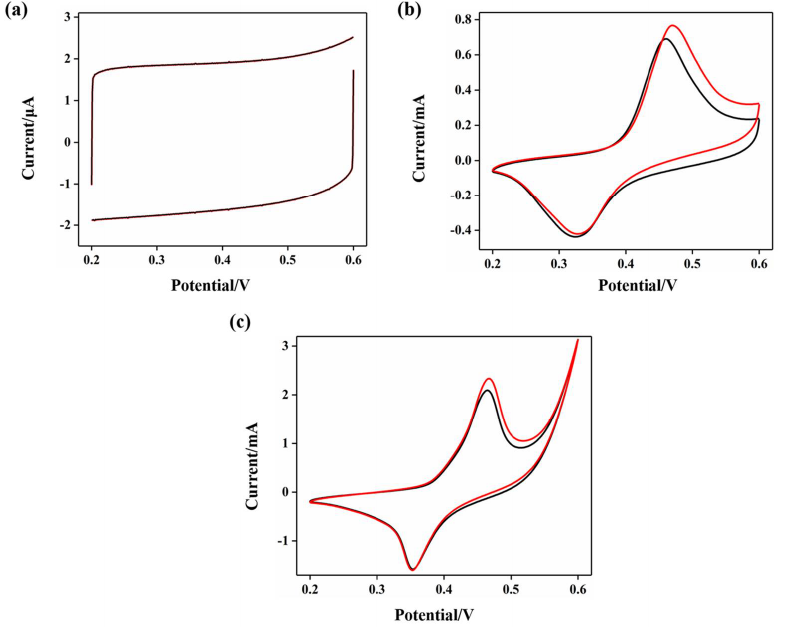
Figure 5. CV curves of different electrodes in 0.5 M NaOH + 1 mM glucose mixed solution (red line) and 0.5 M NaOH solution (black line): ( a ) TNTs; ( b ) Ni−TNTs; ( c ) Ni−DLC/TNTs (all selected the and 0.5 M NaOH solution (black line): ( a ) TNTs; ( b ) Ni − TNTs; ( c ) Ni − DLC/TNTs (all selected the second cycle of CV). second cycle of